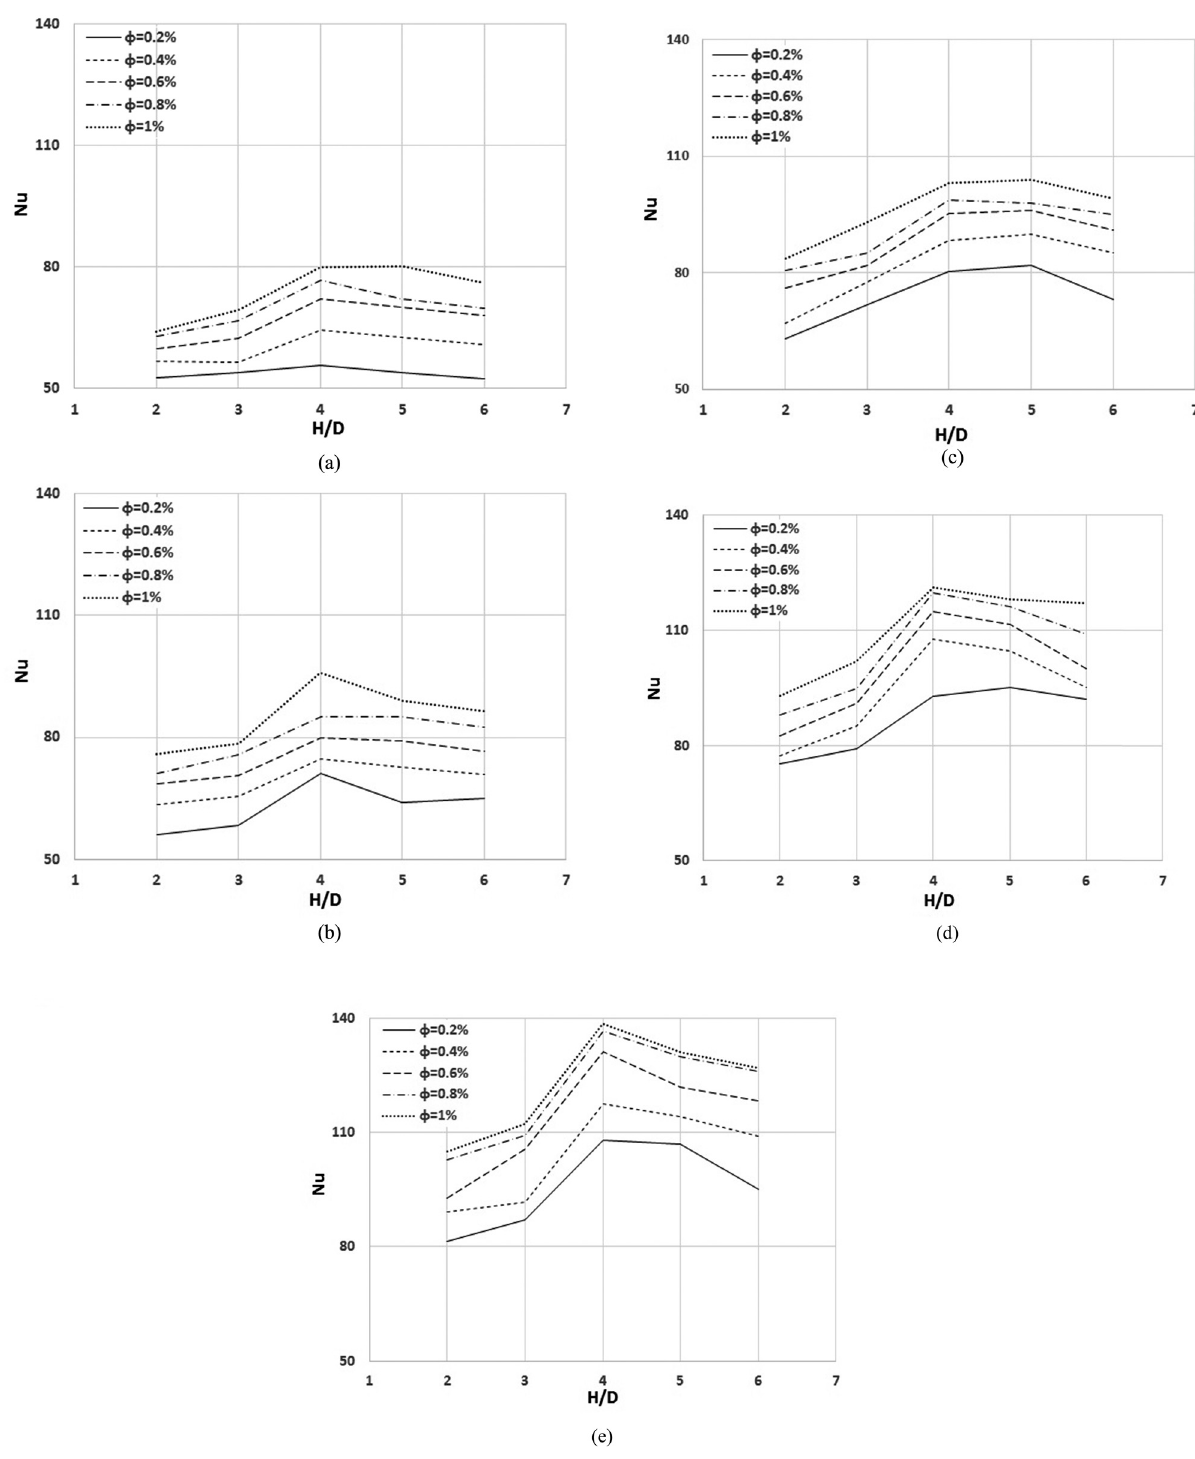
Figure 7: Nozzle - to - target plat ration e ff ect ( a ) H/D = 2, ( b ) H/D = 3, ( c ) H/D = 4, ( d ) H/D = 5, and ( e ) H/D = 6 on Nusselt